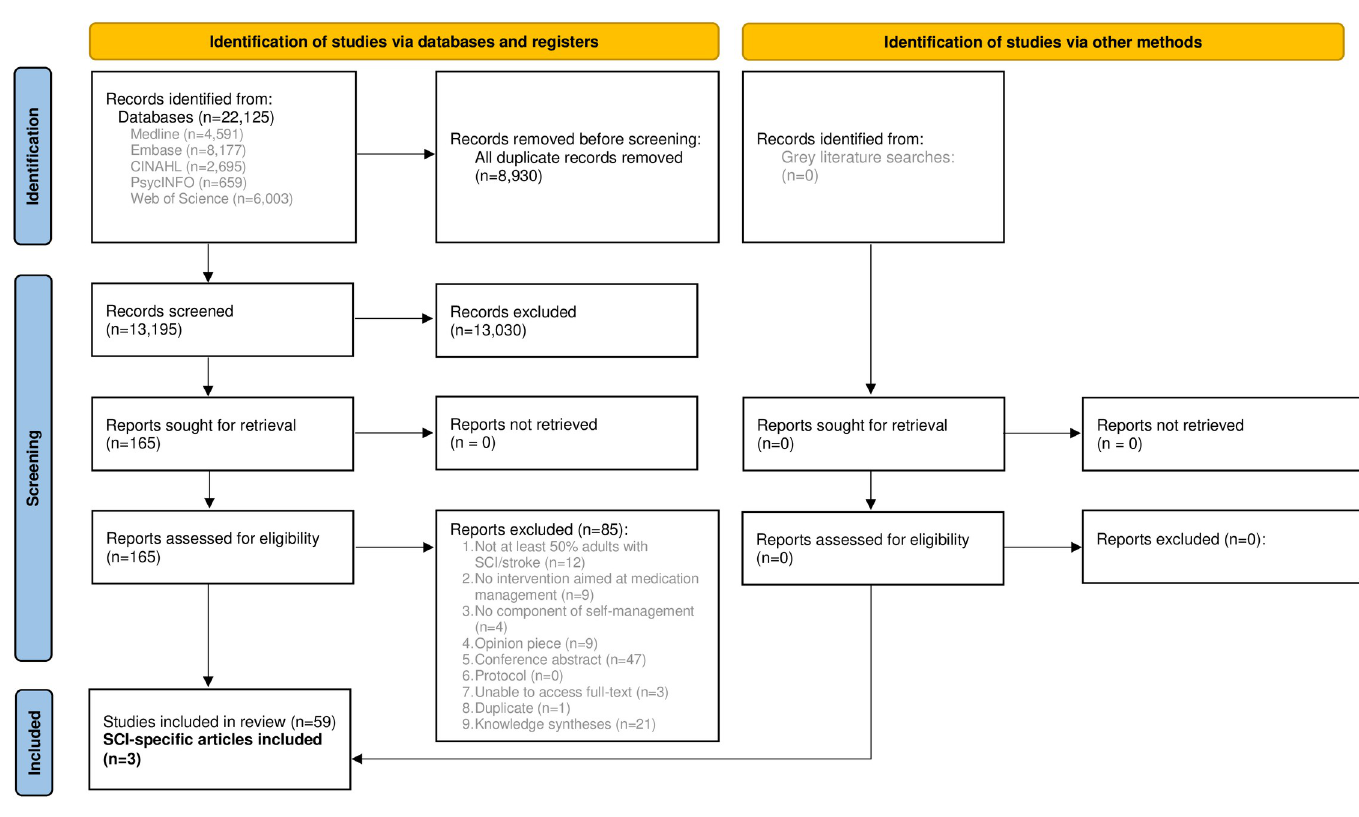
Fig 1. PRISMA flow diagram of included